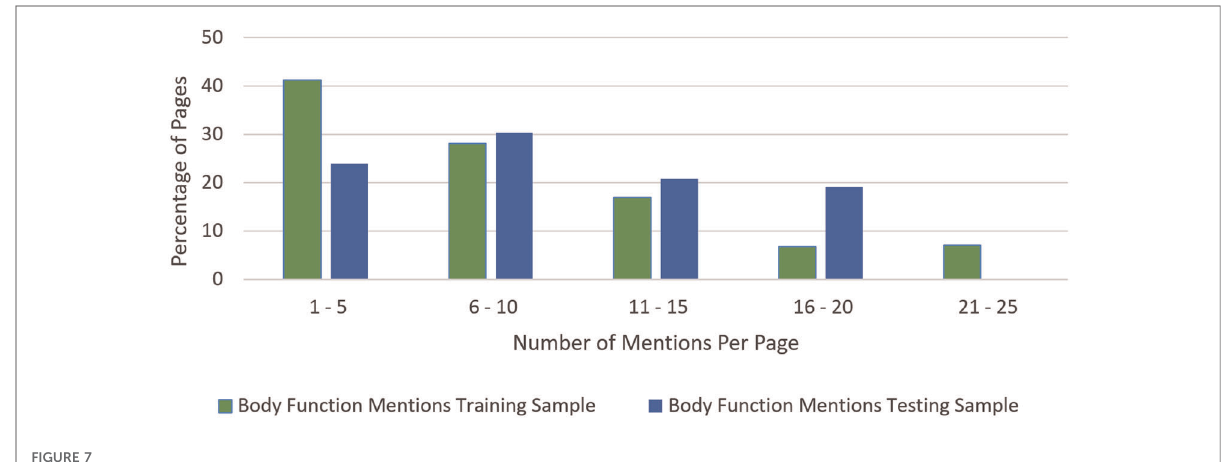
FIGURE 7 Body function mention frequency